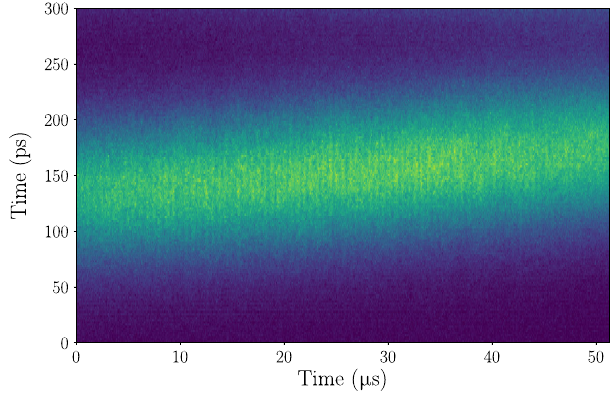
FIG. 16. Beam oscillation observed by a dual-sweep streak camera. Longitudinal profiles of every four bunches are shown along the vertical axis, whereas these profiles are separated along the horizontal axis. The beam oscillation was excited by the phase modulation at a frequency of 5.2 kHz with an amplitude of 0.8° p-p. The cavity voltage was 1.27 MV, and the beam current was 350 mA with a fill pattern of a single train of 250 bunches.